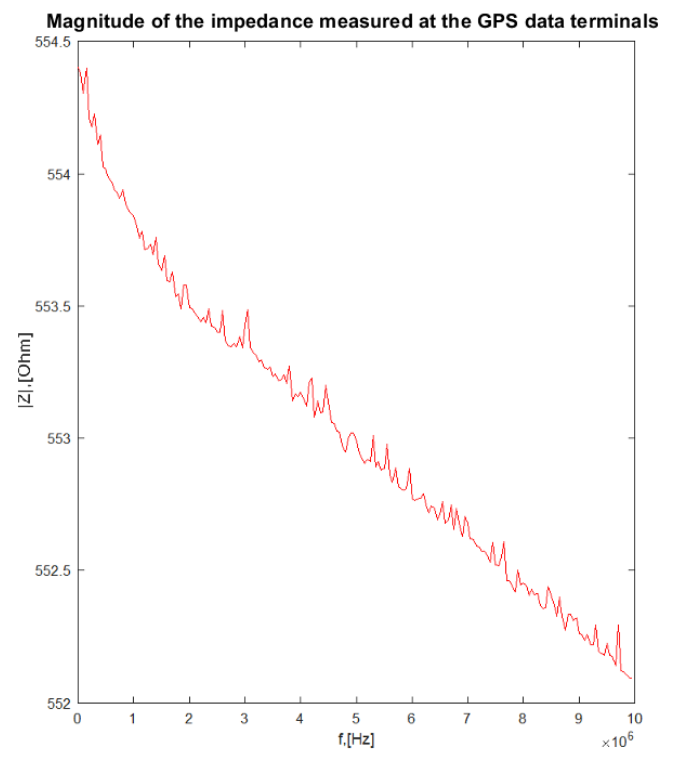
Figure 19. Linear characteristics of the impedance of the GPS data output terminals as a function of frequency.